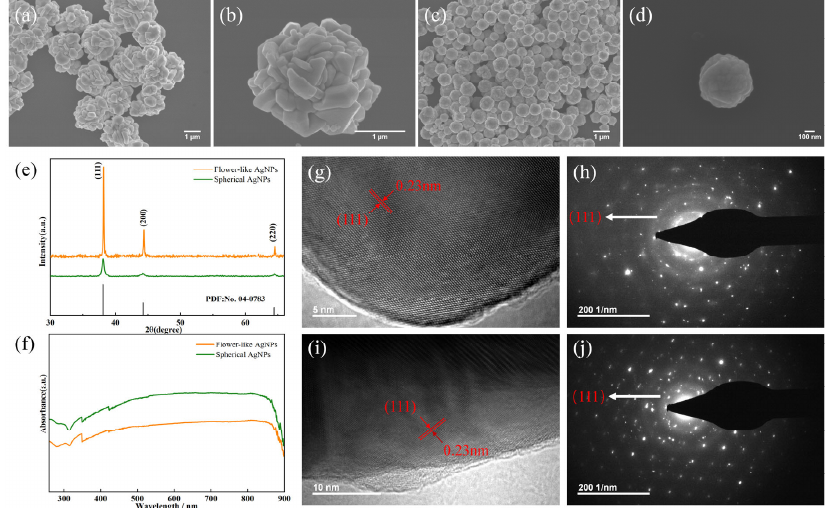
Figure 3. Characterization of silver particles synthesized under different synthesis conditions. ( a,b ) SEM images of the synthesized flower ‐ like silver particles and their detailed morphology; ( c,d ) SEM images of the synthesized quasi ‐ spherical silver particles and their detailed morphology; ( e ) typical XRD spectrum of silver particles; ( f ) UV–Vis absorption spectra of the flower ‐ like silver particles and quasi ‐ spherical silver particles; ( g,h ) HR ‐ TEM and electron diffraction pattern of a selected area of the flower ‐ like silver particles; ( i,j ) HR ‐ TEM and electron diffraction pattern of a selected area of the quasi ‐ spherical silver